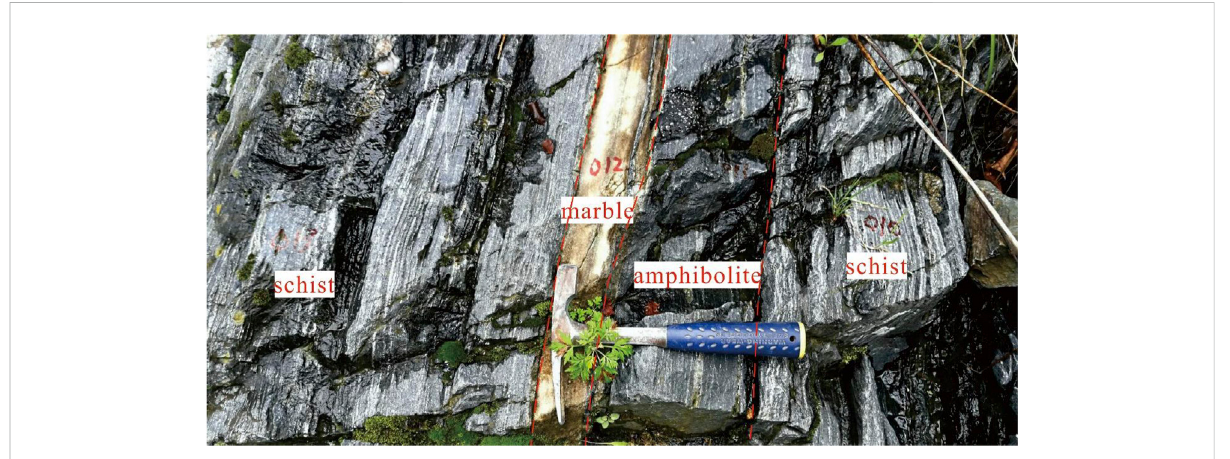
FIGURE 2 Lithological characteristics of the Xunyangba outcrop.